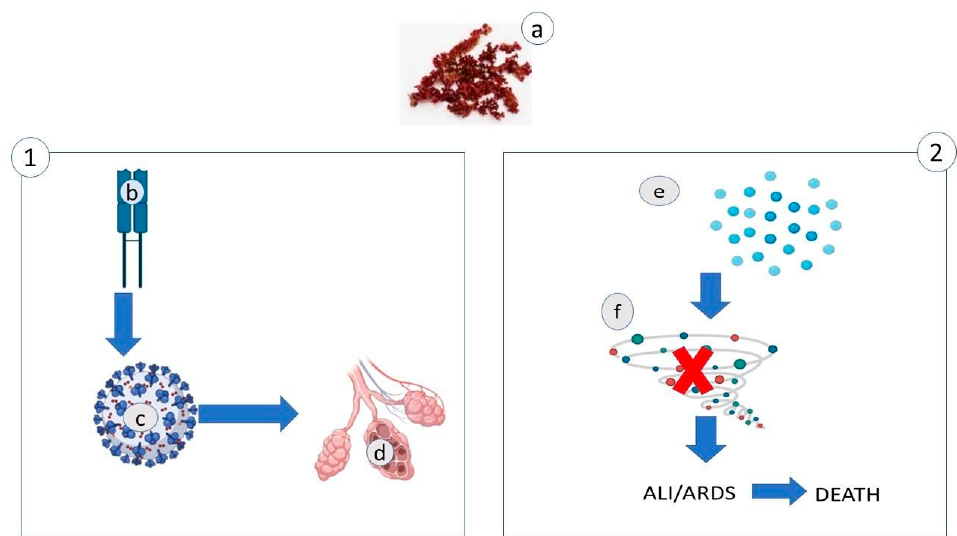
Figure 6. A diet rich in astaxanthin (a) has two possible actions against SARS-CoV-2. First action (1): AST increases the number of lymphocytes (b) in the presence of coronavirus (c) and consequently decreases the oxidative damage of the alveolus (d). Second action (2): AST decreases a specific cytokine (such as IL-6, e), thus preventing cytokine storm (f).